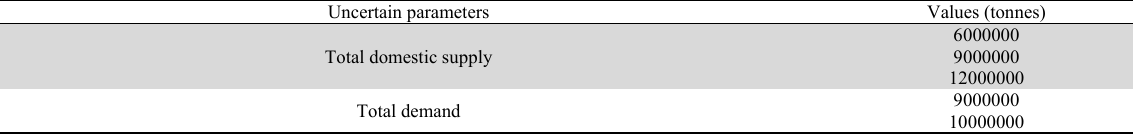
The values of uncertain parameters